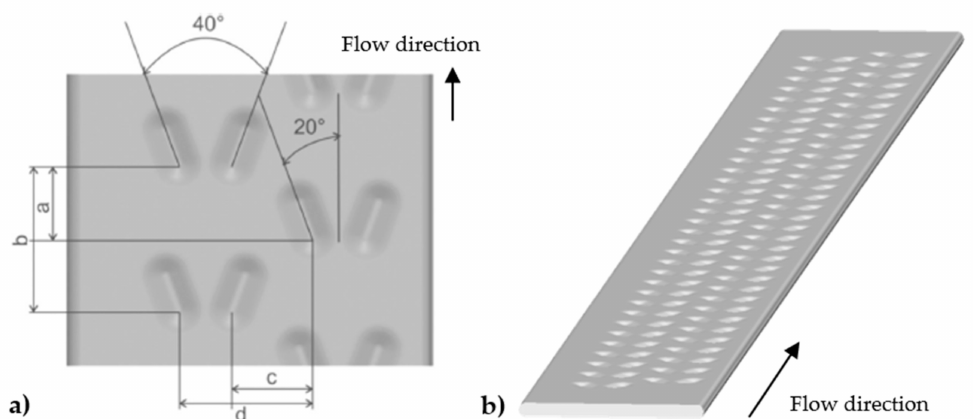
Figure 6. Flat tube with passive inserts (“winglets”) used in automotive industry for flat tube heat exchangers. ( a ): Detailed geometry of passive inserts. b/a = 2; c/d = 0.6. The ratio of the insert height to channels height is 0.325. ( b ): Left channel of the corresponding flat tube with l = 220 mm length and passive inserts used in automotive industry. Reproduced with permission from [16], published by Elsevier